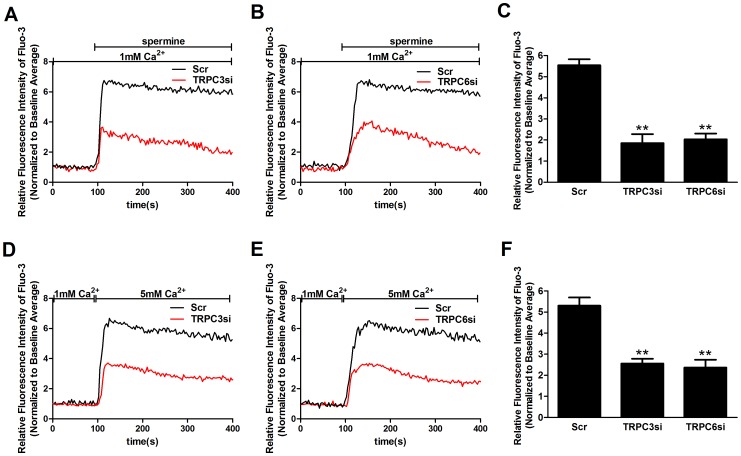
TRPC3 and TPRC6 are involved in the CaSR agonist-induced [Ca2+]i increase.[Ca2+]i dynamics were monitored by Fura-3 fluorescence methods. (A, B) Representative traces showing that transfection with TRPC3 siRNA (A) or TRPC6 siRNA (B) significantly inhibit the 3 mM spermine-induced [Ca2+]i increase (p<0.05 vs. Scr, n = 5), respectively, in contrast with cells transfected with scrambled siRNA. (C) Summary of data showing that transfection with TRPC3 siRNA or TRPC6 siRNA significantly inhibits the average value of the plateau of the 3 mM spermine-induced [Ca2+]i increase (**p<0.01 vs. Scr, n = 5), respectively. (D, E) Representative traces showing that transfection with TRPC3 siRNA (D) or TRPC6 siRNA (E) significantly inhibits the 5 mM [Ca2+]o-induced [Ca2+]i increase (p<0.05 vs. Scr, n = 5), respectively, in contrast with cells transfected with scrambled siRNA. (F) Summary of data showing that transfection with TRPC3 siRNA or TRPC6 siRNA significantly inhibits the average value of the plateau of the 5 mM [Ca2+]o-induced [Ca2+]i increase (**p<0.01 vs. Scr, n = 5), respectively. Data are shown as the means ± SEMs. The results were from at least three independent experiments, and each experiment measured 20 to 40 cells.